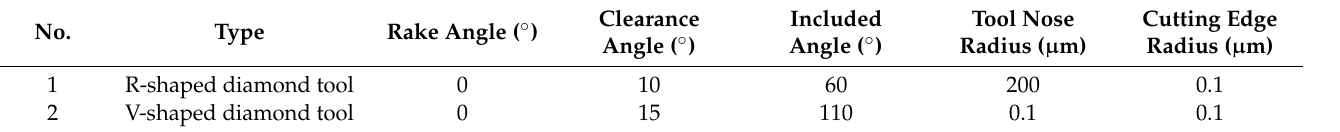
Table 2. Tool geometry parameters.